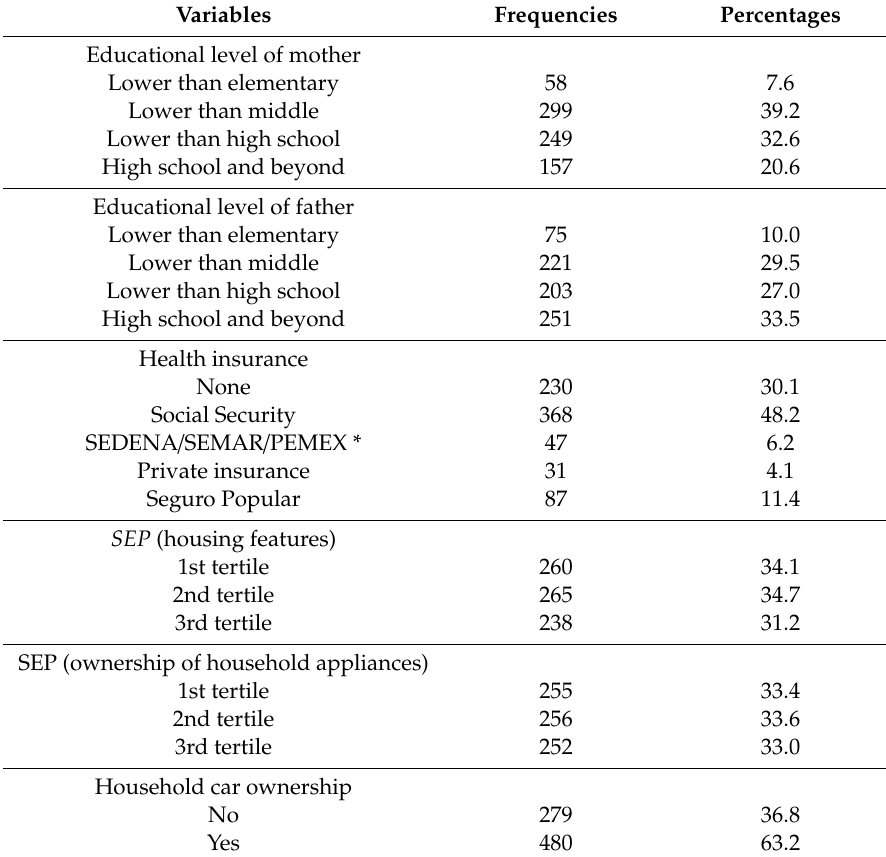
Table 2. Description of the socioeconomic variables in the study sample.